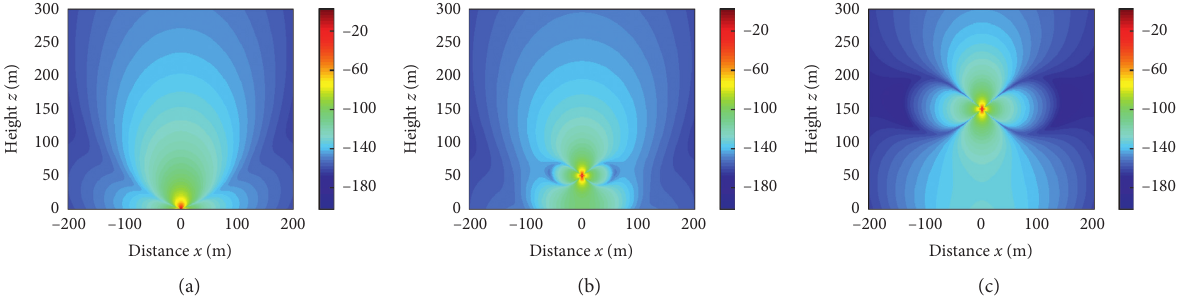
Figure 9: Field distribution of H